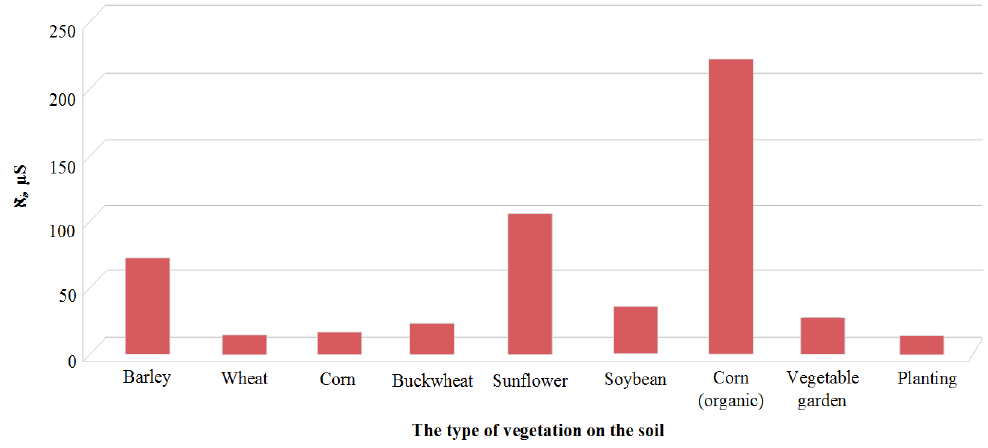
Fig. 3. Data of the electrical conductivity of the studied samples of agricultural soils in the fields where different crops grew (barley, wheat, corn, buckwheat, sunflower, soybean) and reference points (vegetable garden, planting). Organic fertilizers (manure, humus, etc.) are known to contain nutrients [35] in a safe form for plants and the environment. Accordingly, that is why they are recommended for use by Council Regulation (EC) No. 834/2007 [15] and Commission Regulation (EC) No. 889/2008